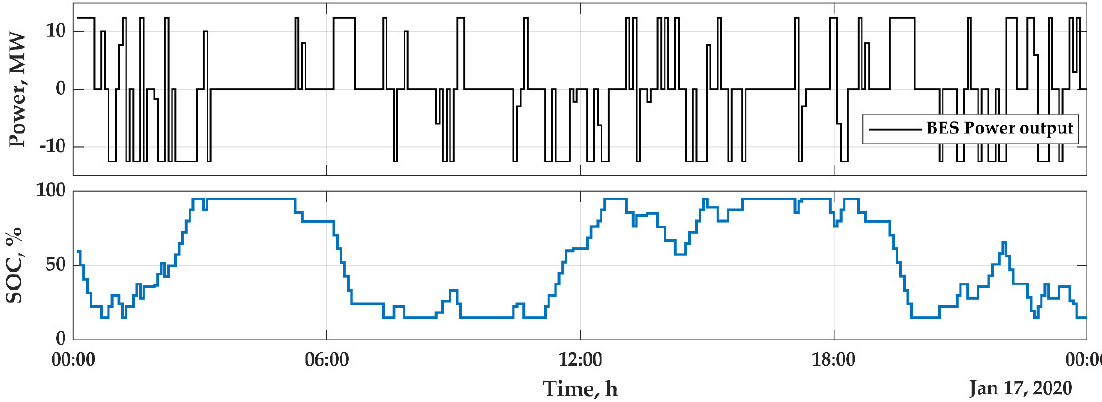
Figure 9. Battery charge and discharge actions ( top ) and resulting SOC ( bottom ) under Strategy 1 (maximization of revenue from spot energy market) for a single day of operation with market prices.